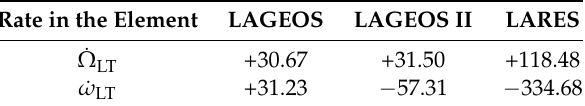
Table 2. Rate, in millisecond of arc per year (mas/yr), for the secular Lense–Thirring precession on the right-ascension of the ascending node and on the argument of pericenter of LAGEOS, LAGEOS II, and LARES